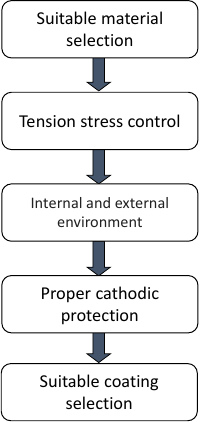
Figure 2. Factors that must be considered to prevent SCC development in pipelines.